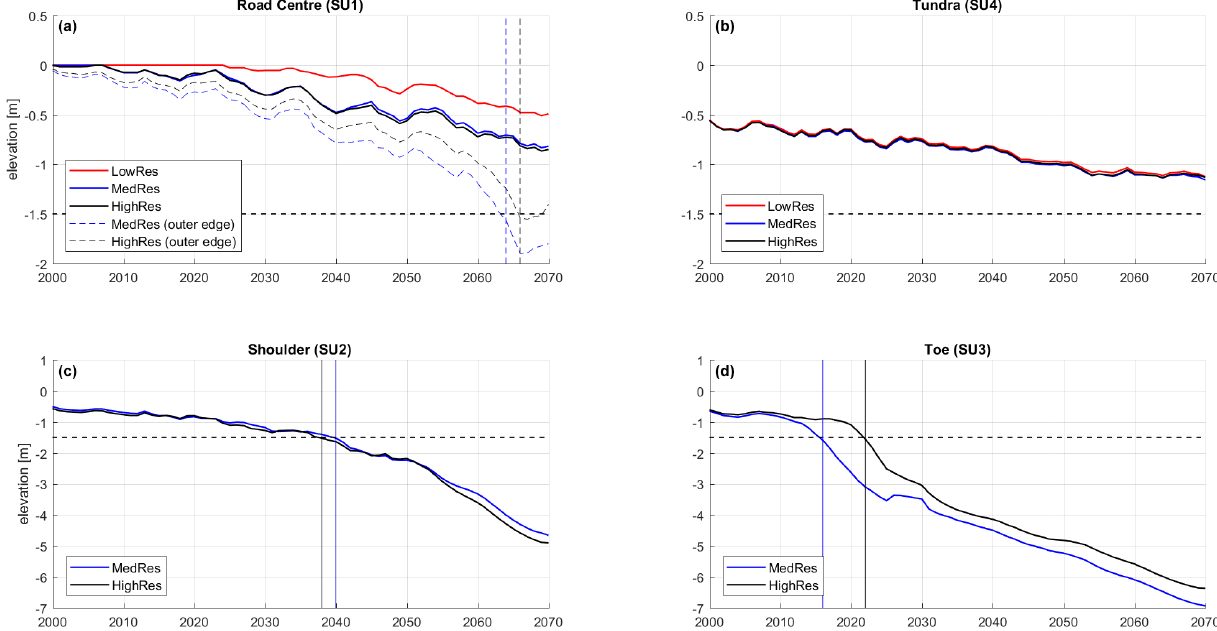
Figure 6. Temporal evolution of the maximum thaw depth (MTD) under gravel road (a, c) and tundra conditions (b, d) for different lateral model resolutions. Shown is the 5-year mean of maximum thaw depth (MTD) under RCP8.5 warming for low horizontal model resolution (two tiles, red lines), medium resolution (vulnerable setting, five tiles, blue curves), and high resolution (vulnerable setting, 30 tiles, black curves). Also shown is the outer edge of the road centre ( a , dashed lines). The vertical lines indicate the first occurrence of an MTD exceeding the embankment depth (dashed horizontal line). Note the difference in y -axis scales between upper and lower